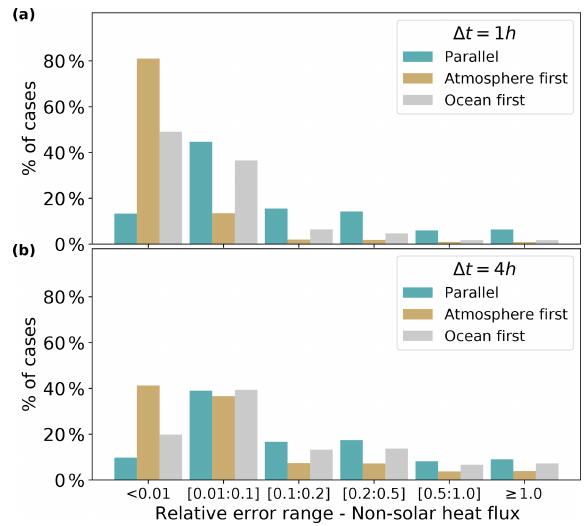
Figure C1. Same as Fig. 5, but for the non-solar heat flux, showing the relative error of the change in the non-solar heat flux during a coupling period. The error is computed as the ratio between (i) the correction due to the iterative procedure (the jump from green dots to the converged solution in grey in Fig. 3) and (ii) the solution change between t and t + (cid:49)t with no Schwarz iteration (the jump from yellow to green dots in Fig. 3). See the legend in Fig. 4 for the explanation of the x